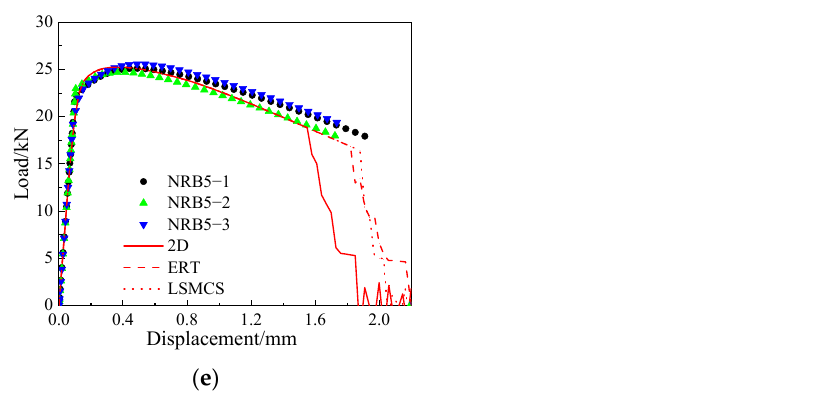
Figure 16. Function relationship between tensile strength and average stress triaxiality. Table 4. Average stress triaxiality and tensile strength of notched specimens. NRB1